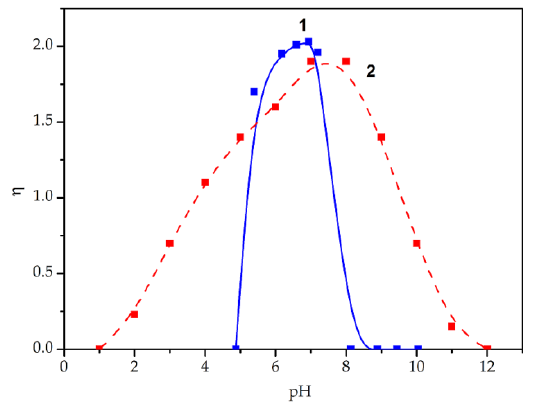
Figure 5. The dependence of the luminescence efficiency on the pH in C 12 EO 10 micelles: 1 . Tb(Phen) and 2 . Tb(Phen)-AA, C AA = 1.2 × 10 − 5 M. and 2 . Tb(Phen)-AA, C × 10 − 5 AA = 1.2